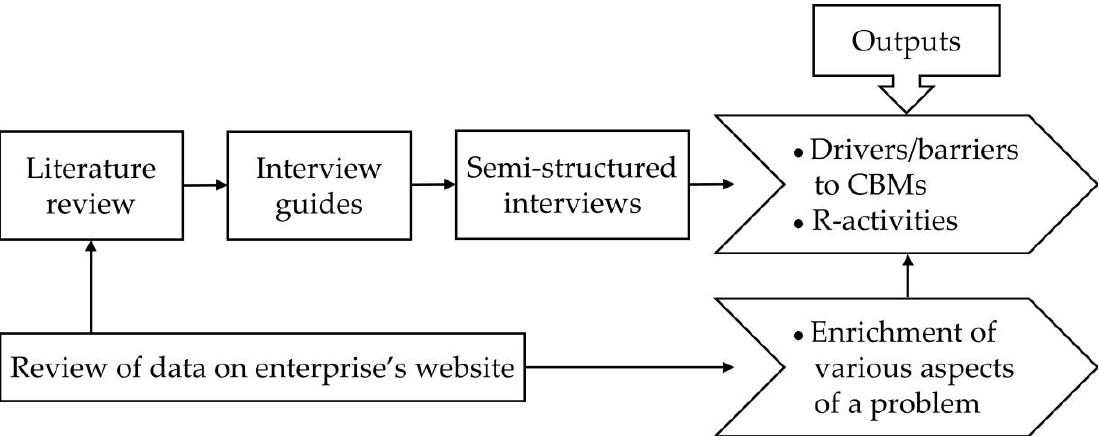
Figure 1. Research methodology review. Source: own